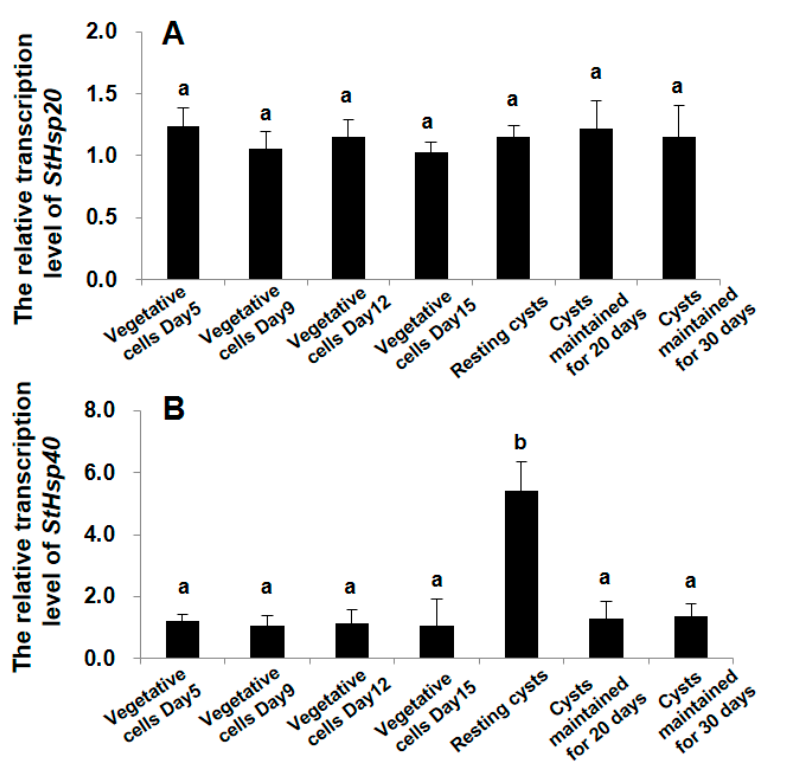
Figure 6. Transcription profiles of StHsp20 ( A ) and StHsp40 ( B ) in cells or resting cysts at different stage of life cycle. Different letters show significant differences ( p < 0.05). Error bars represent the standard deviation from 3 replicates.